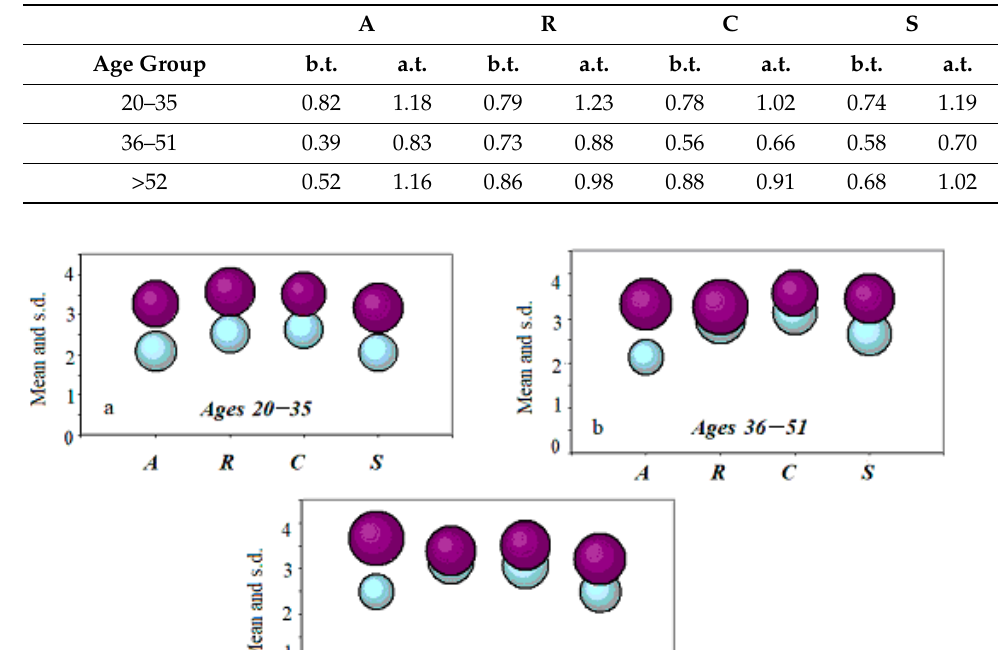
Table 4. Standard deviations of the participants’ answers per ARCS factor and per age group, before training (b.t.) and after training (a.t.). A R